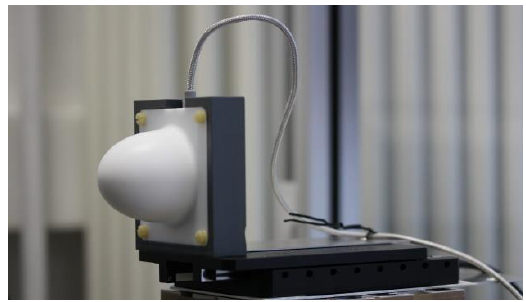
Figure 6. 60 GHz FMCW radar.